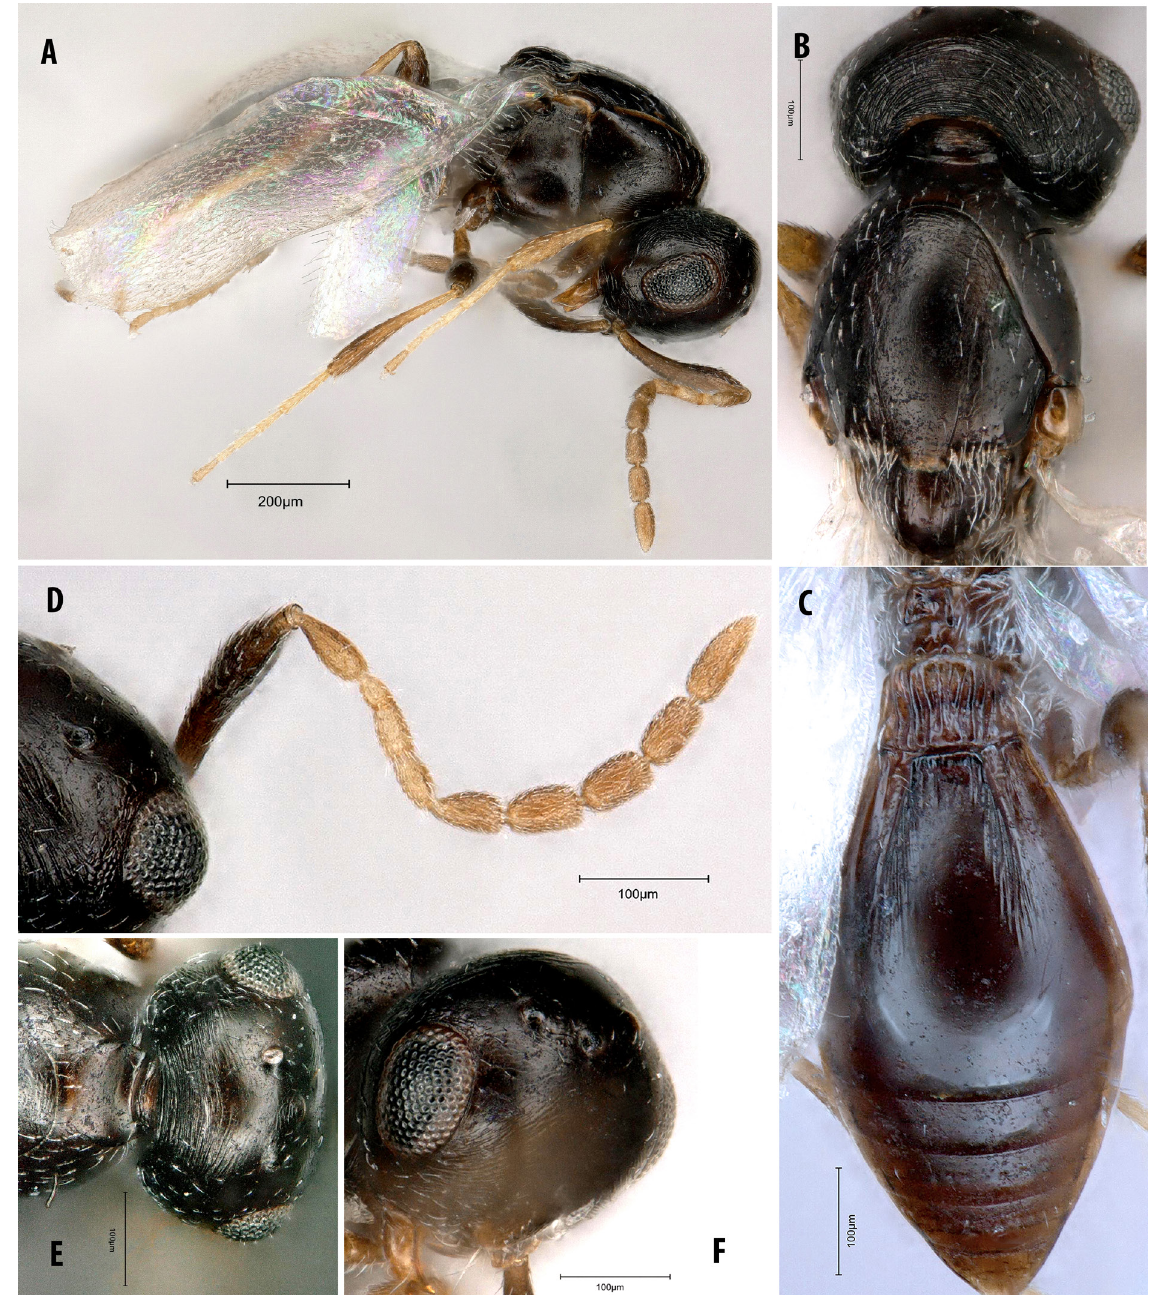
Fig . 2 . Platygaster karimpouri Asadi & Buhl sp. nov., holotype, ♀ (HMIM). A . Habitus in lateral view. B . Head and mesonotum in dorsal view. C . Metasoma in dorsal view. D . Antenna. E . Head and pronotum in dorsal view. F . Head in latero-frontal view. Scale bars: A =200 µm; B–F = 100